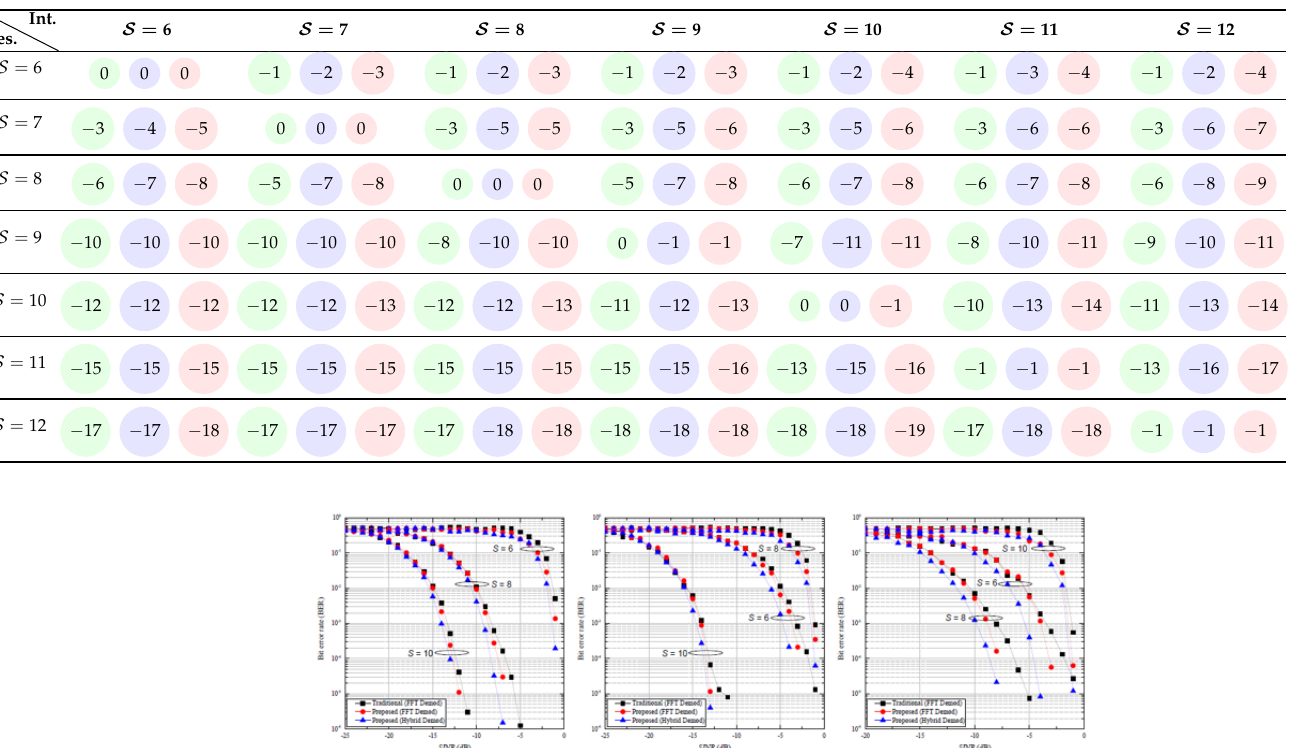
= 8; ( c ) interference signal S